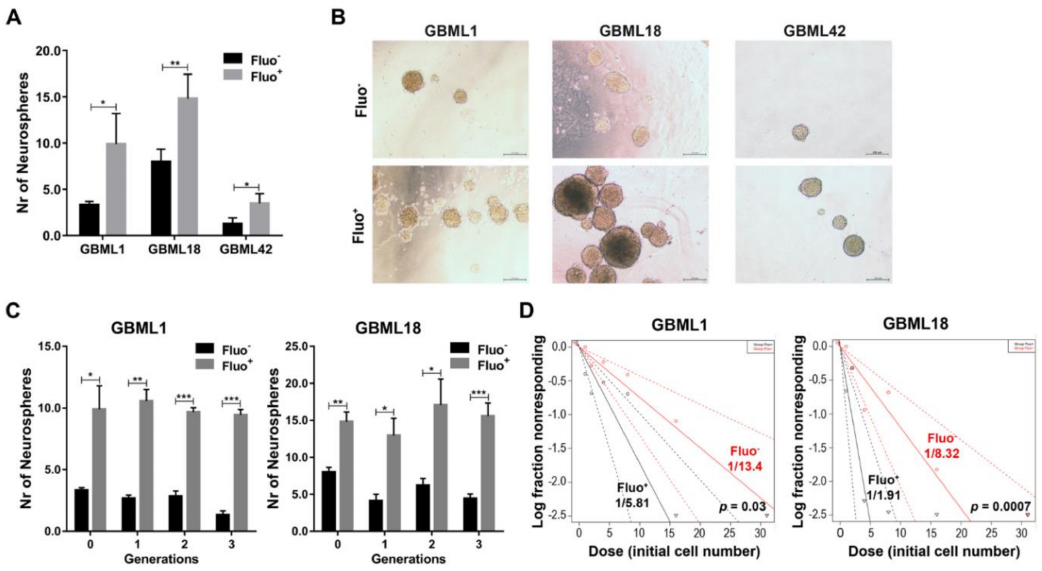
Figure 3. Autofluorescent GBM cells have a higher self–renewal ability. ( A ) Quantification of neurospheres in Fluo − and Fluo + GBM cells sorted from GBML1, GBML18 and GBML42 ( n ≥ 3; each performed at least in triplicate). ( B ) Representative phase contrast photographs of GBM Fluo − and Fluo + neurospheres from GBML1, GBML18 and GBML42. ( C ) Quantification of neurospheres in Fluo − and Fluo + sorted cells from human primary GBM cultures GBML1 and GBML18, after three consecutive passages/generations ( n = 3, each performed at least in triplicate). ( D ) Representative LDA analyses of GBML1 and GBML18 Fluo − (red) and Fluo + (black) sorted cells. The graphs are representative of two independent assays for each culture, with similar results. The trend lines represent the estimated active cell frequency ( p = 0.03 for GBML1 and p = 0.0007 for GBML18, likelihood ratio test). Data are representative as the mean ± SD of at least two independent experiments